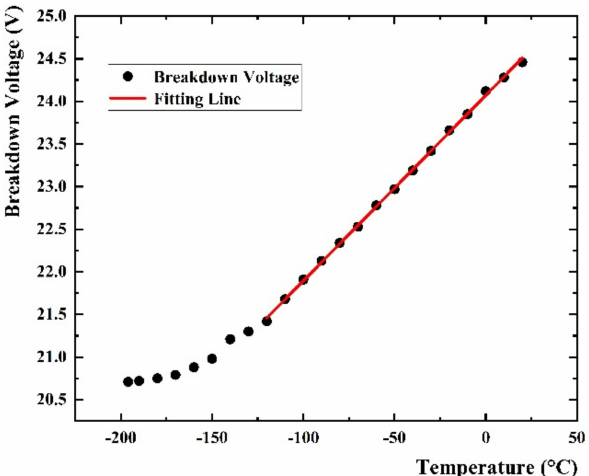
Figure 4. ( a ) Current vs. bias voltage plot at room temperature; ( b ) room temperature.